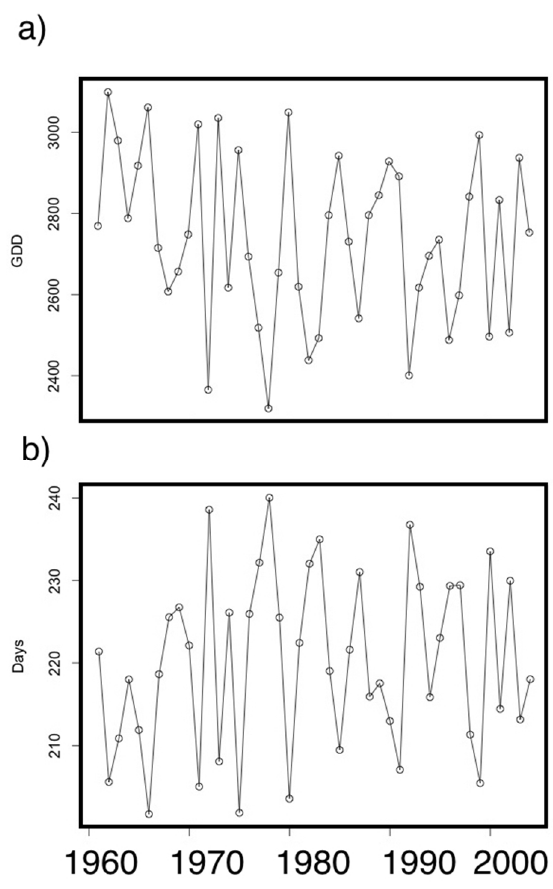
Figure 3. ( a ) Mean number of Growing Degree Days (GDD) over the region, and ( b ) mean number of days until reaching the target GDD (1825 °C) during the historical period.